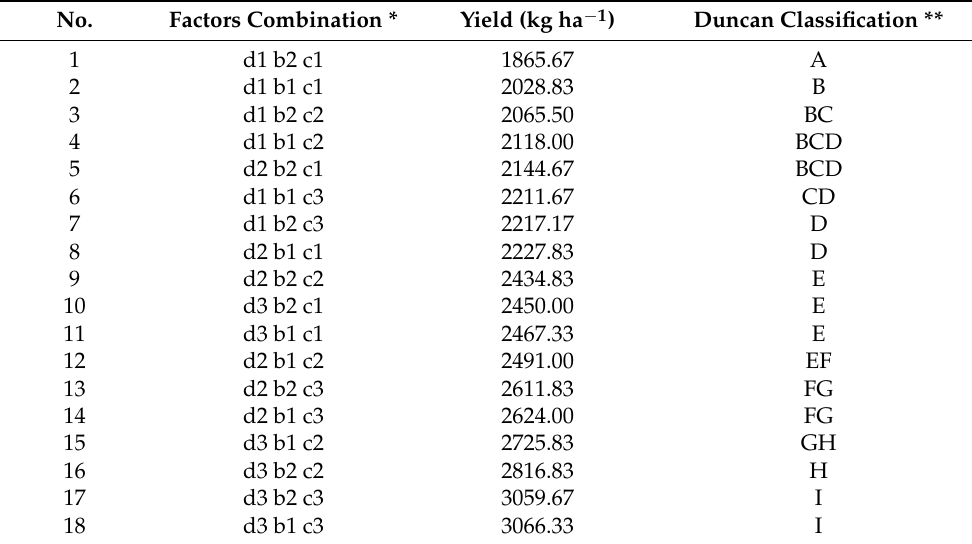
Table 5. Synthesis of yield comparisons by technological